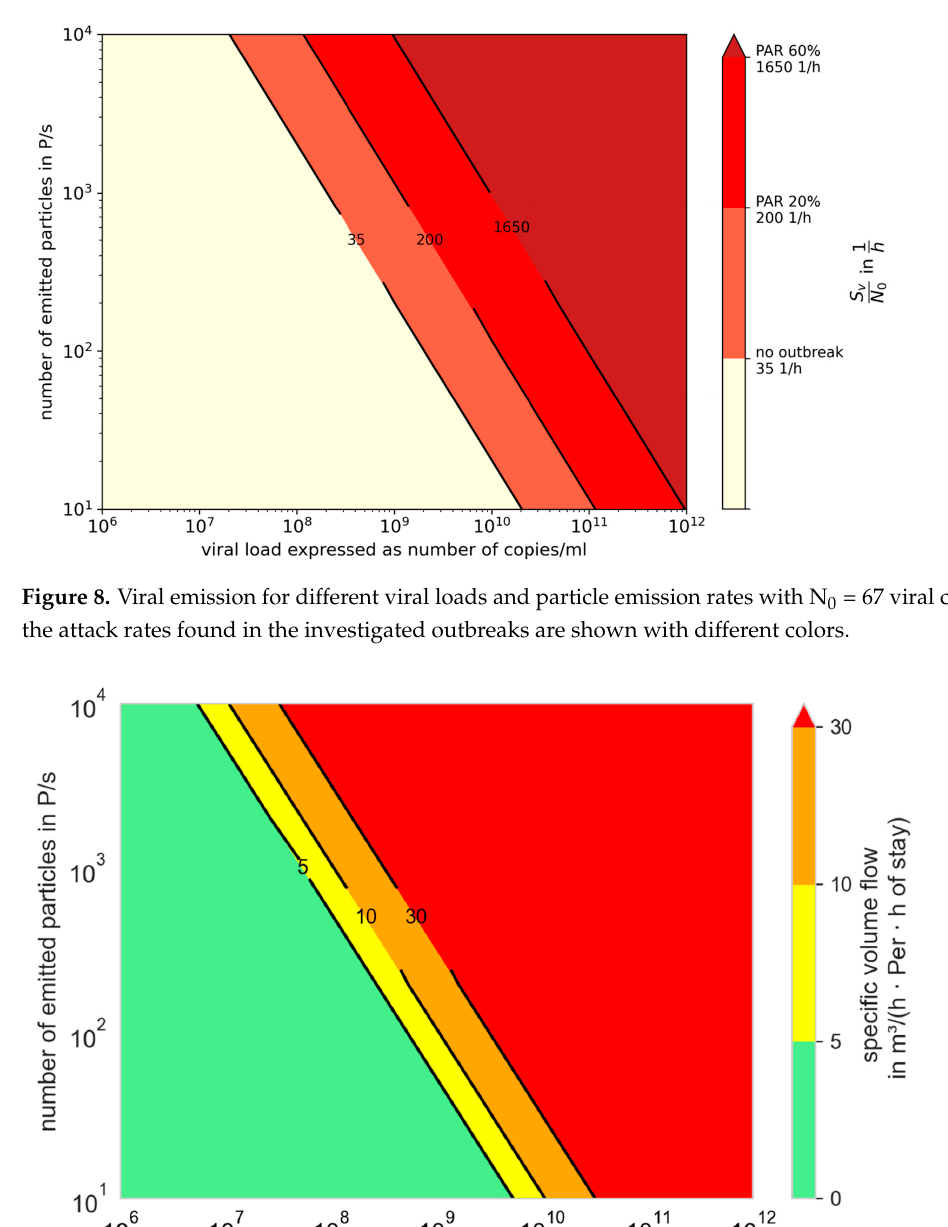
Figure 9. Specific volume flow depending on the number of emitted, particles and the viral load to limit the number of newly infected persons to one; N 0 = 67 viral copies, f M = 1, Q b,in = Q b,e = 0.54 m 3 /h.